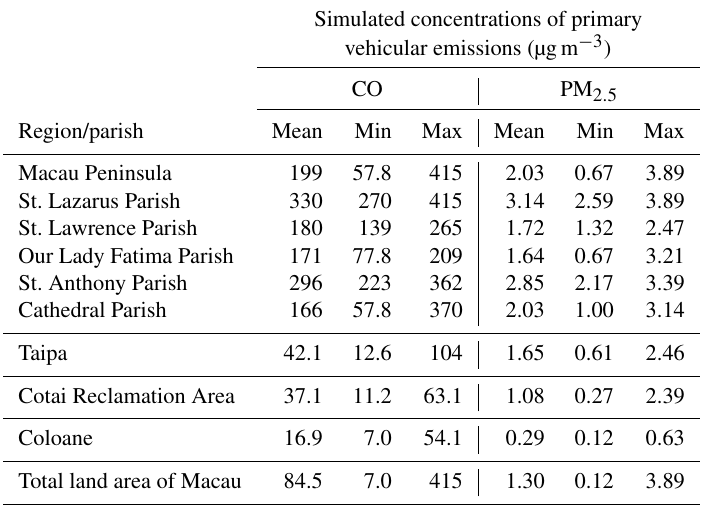
Table 7. Simulated average contributions contributed by primarily vehicular emissions in Macau, weekdays during November 2010. Simulated concentrations of